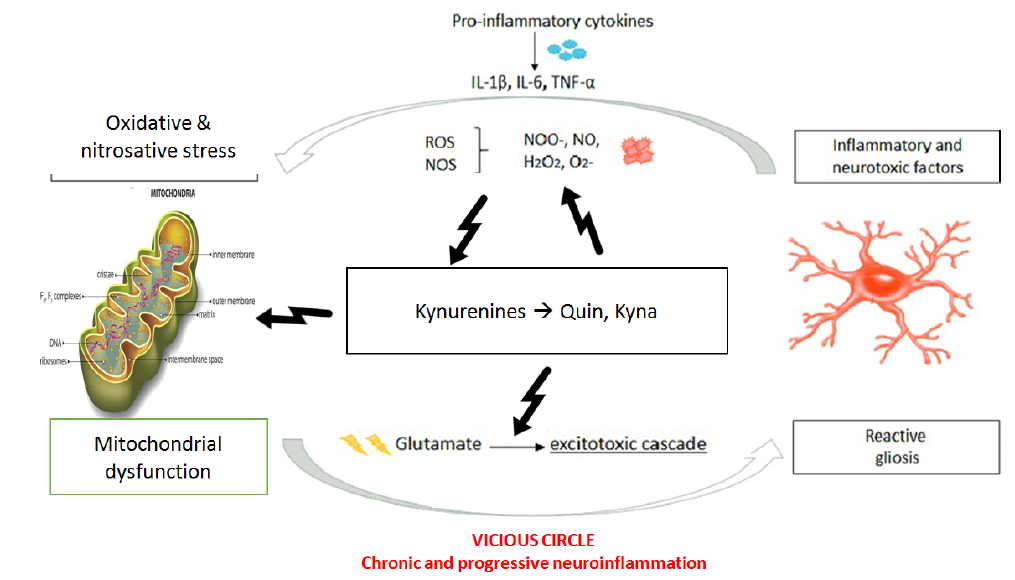
Figure 2. Inflammation significantly shifts tryptophan metabolism to Kynurenine production by activation of activate indole-2,3-dioxygenase (IDO) and Kynurenine monooxygenase (KMO) microglial enzymes. Quinolinic acid (QUIN) is involved in neurotoxicity since it activates N-methyl-D-aspartate (NMDA) receptors, increases neuronal activity, and elevates intracellular calcium concentrations. This leads to the consequent impairment of cytoskeleton homeostasis, decrease of mitochondrial function and finally cell death induction. As an NMDA agonist, it increases neuronal glutamate release, inhibits its uptake by astrocytes, and inhibits astroglial glutamine synthetase leading to excessive microenvironmental glutamate concentrations. In addition, QUIN contributes to free radical generation and oxidative stress.